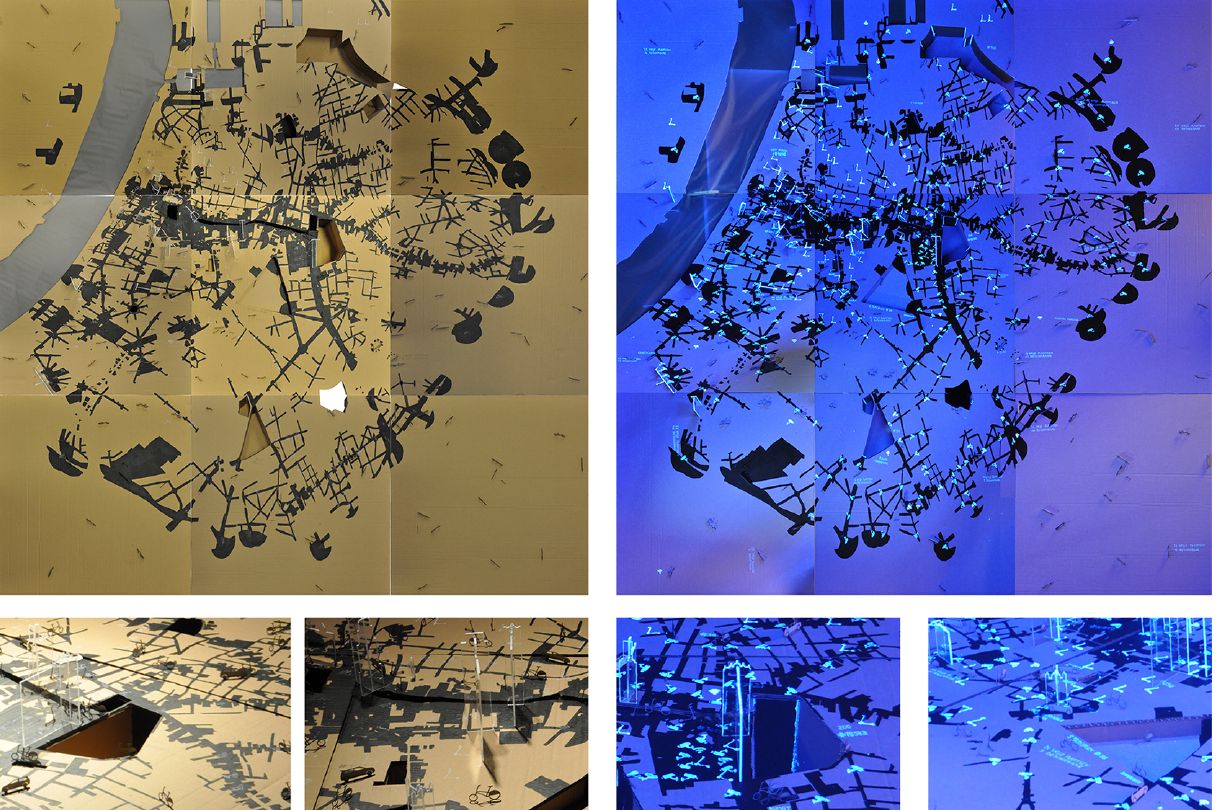
Figure 1. The two configurations of the ‘Analogue City’ map: under ordinary light (left) and under UV-light (right). The UV-lights were turned on upon filling out a questionnaire about the influence of digital devices on the city of Antwerp. Source: The ‘Analogue City,’ IDW University of Antwerp 2019 students, and the